Question: Write a descriptive caption for this figure.
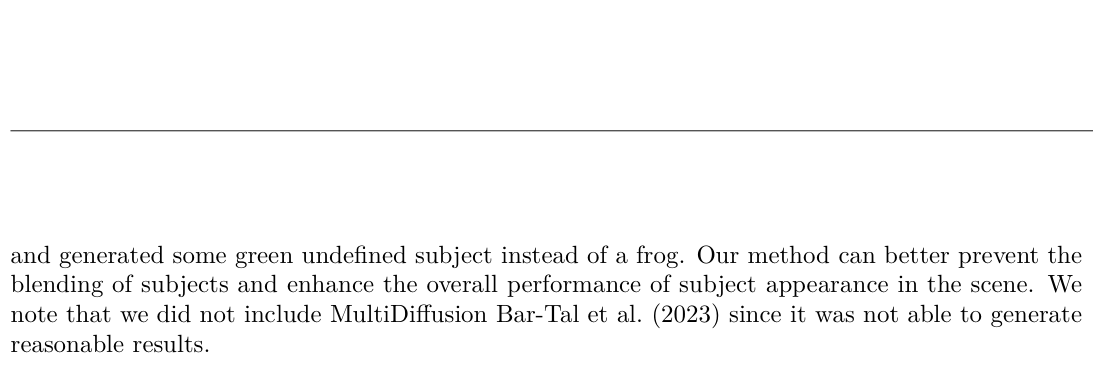
Answer: This figure displays the output generated by our method in response to the prompt: "A chicken and a duck with a ball at the beach." and "A dog, a cat, and a bear at the beach". The three rightmost images depict the attention maps at step 9, a pivotal moment in the generation process that significantly influences the layout of the generated image. This step was specifically chosen to highlight its critical role in determining the spatial arrangement of the depicted entities. This visualization helps us analyze the importance of separating the attention maps.